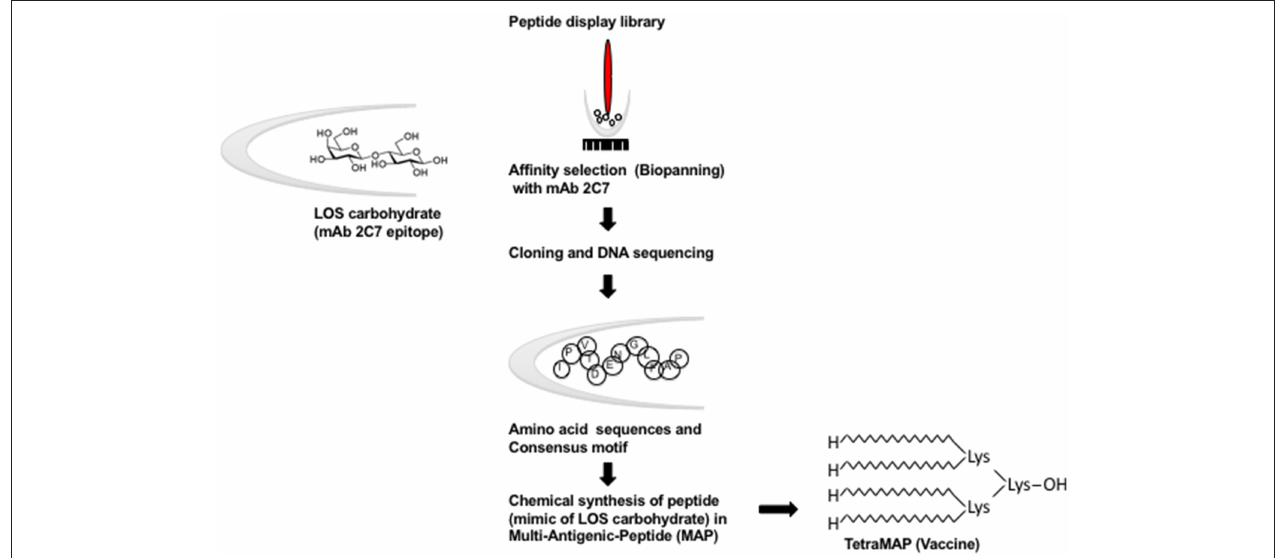
FIGURE 3 | Schematic representation of the conversion of carbohydrate (OS) epitopes into peptide mimotopes. Peptide mimics of the 2C7 epitope were identified using a random FliTrx (Flagellin-Thioredoxin) peptide display library that were screened (Biopanned) using mAb 2C7 (98). The peptide–containing clones that bound to mAb 2C7 were eluted and sequenced. An optimal peptide that contained the consensus motif was synthesized as an octameric peptide (shown here as a multiantigenic peptide [MAP]) on a lysine backbone (TetraMAP), which is the currently used